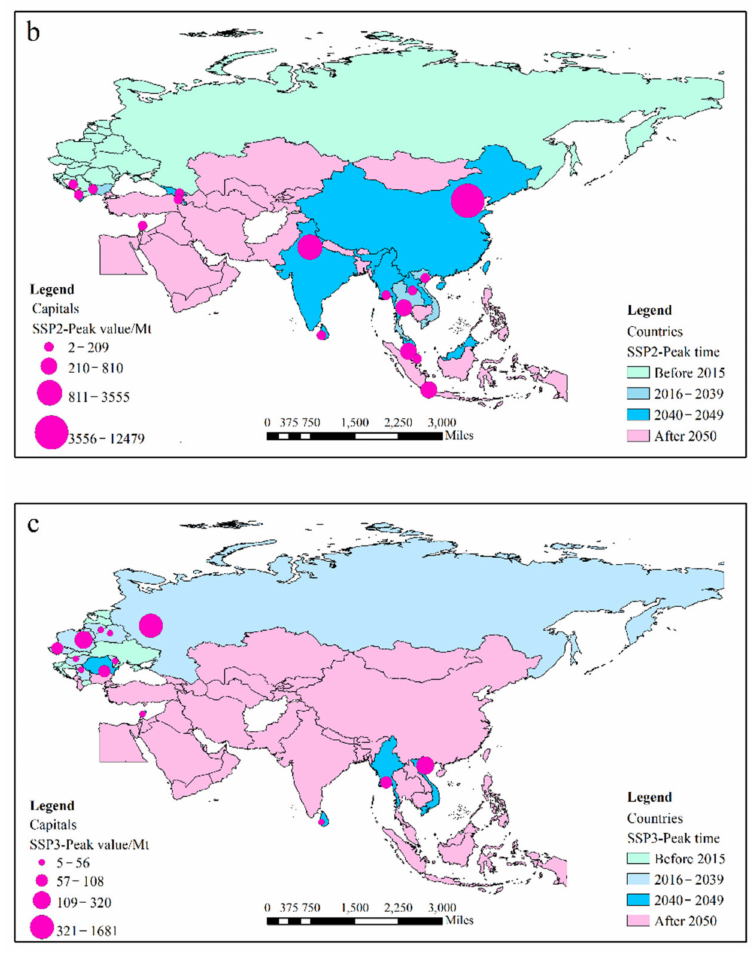
Figure 7. Peak emission and time for 60 B&R countries under ( a ) SSP1, ( b ) SSP2, ( c )